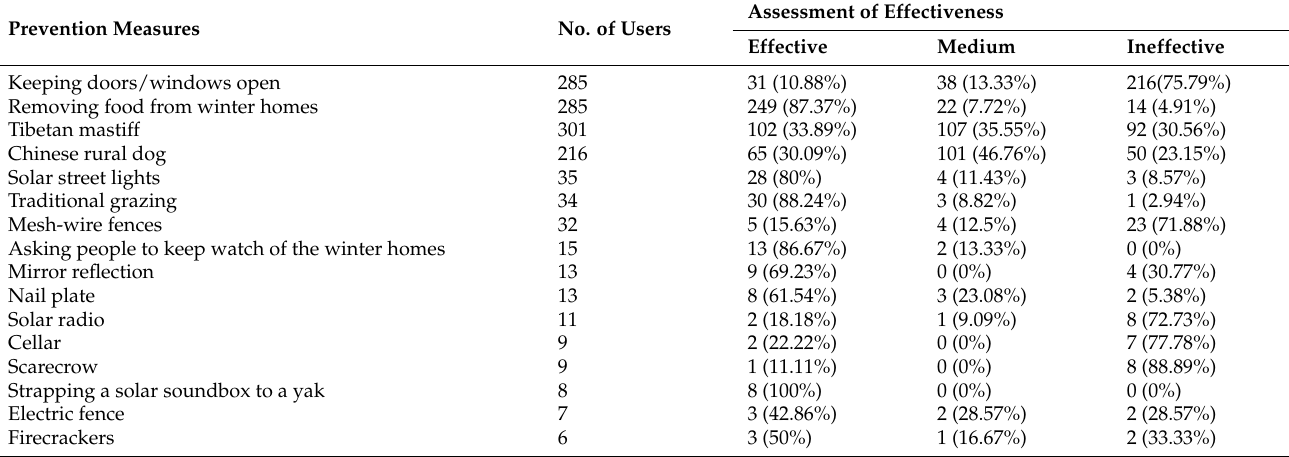
Table 3. Assessment of the effectiveness for the current mitigation